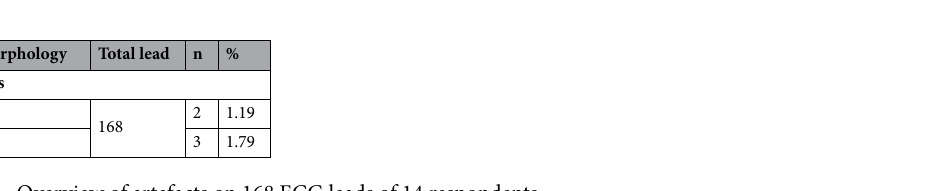
Table 2. Overview of artefacts on 168 ECG leads of 14